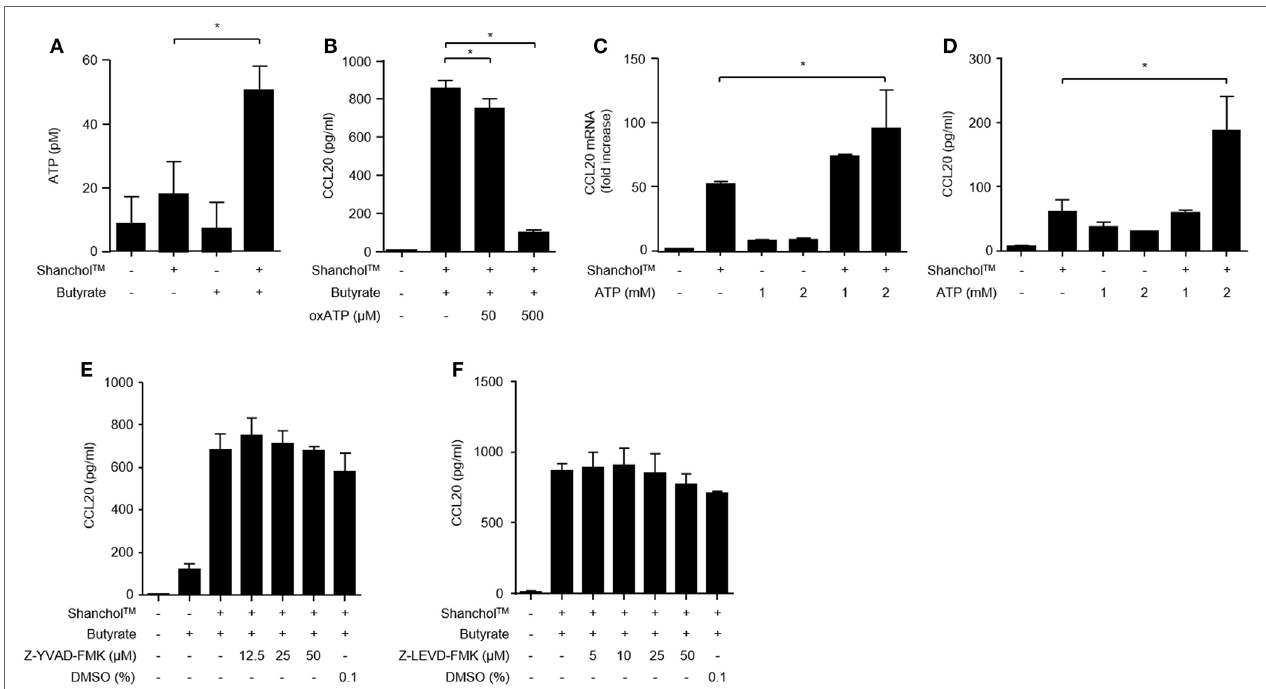
FigUre 4 | ATP is required for CCL20 secretion from Caco-2 cells. (a) Caco-2 cells were incubated with Shanchol ™ in the presence or absence of 10 mM butyrate for 2 h. Then, the culture supernatants were collected, and extracellular ATP production was measured. (B) Caco-2 cells were pretreated with 50 or 500 µM of oxATP for 1 h and subsequently stimulated with Shanchol ™ and butyrate for an additional 24 h. Then, the culture supernatants were collected, and the concentrations of secreted CCL20 were measured by ELISA. Data shown are representative of three independent experiments. (c) Caco-2 cells were stimulated with the indicated concentration of ATP in the presence or absence of Shanchol ™ for 3 h. Total RNA was isolated, and the mRNA expression level of CCL20 was determined by real-time RT-PCR. (D) Caco-2 cells were stimulated with the indicated concentration of ATP in the presence or absence of Shanchol ™ for 24 h. Then, the culture supernatants were collected, and the secreted CCL20 was measured by ELISA. (e,F) Caco-2 cells were pretreated with the indicated concentrations of the caspase-1 inhibitor (Z-YVAD-FMK) (e) , the caspase-4 inhibitor (Z-LEVD-FMK) (F) , or DMSO (vehicle control) for 1 h and subsequently stimulated with Shanchol ™ and butyrate for an additional 24 h. Then, the culture supernatants were collected and the CCL20 secretion was measured by ELISA. Data shown are representative of three independent experiments. All results are expressed as mean ± SD of triplicate samples. The asterisk (*) indicates a statistically significant difference ( P < 0.05) compared with the appropriate